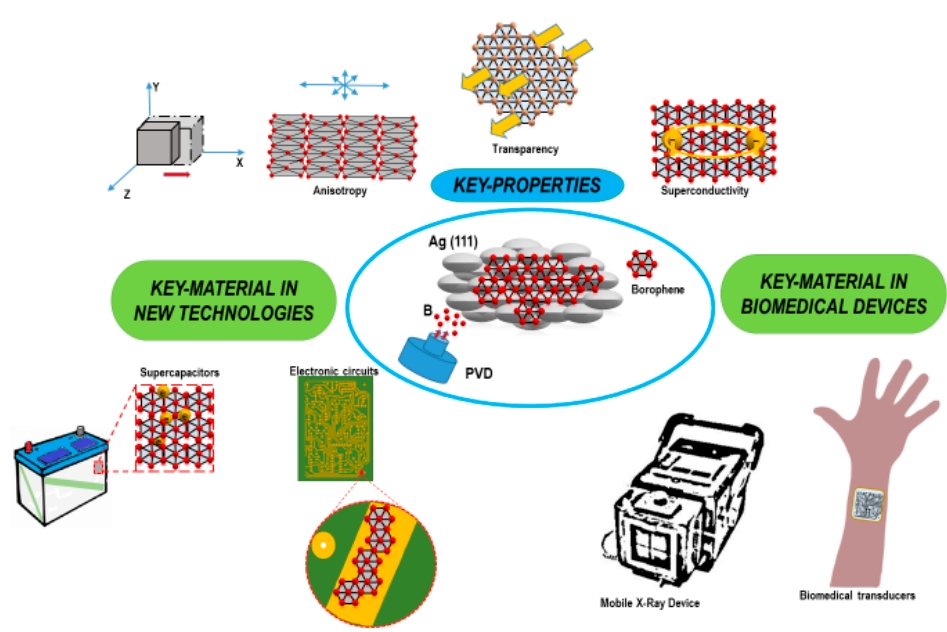
Figure 5. Strategic applications of borophene (BO) in biomedical fields.